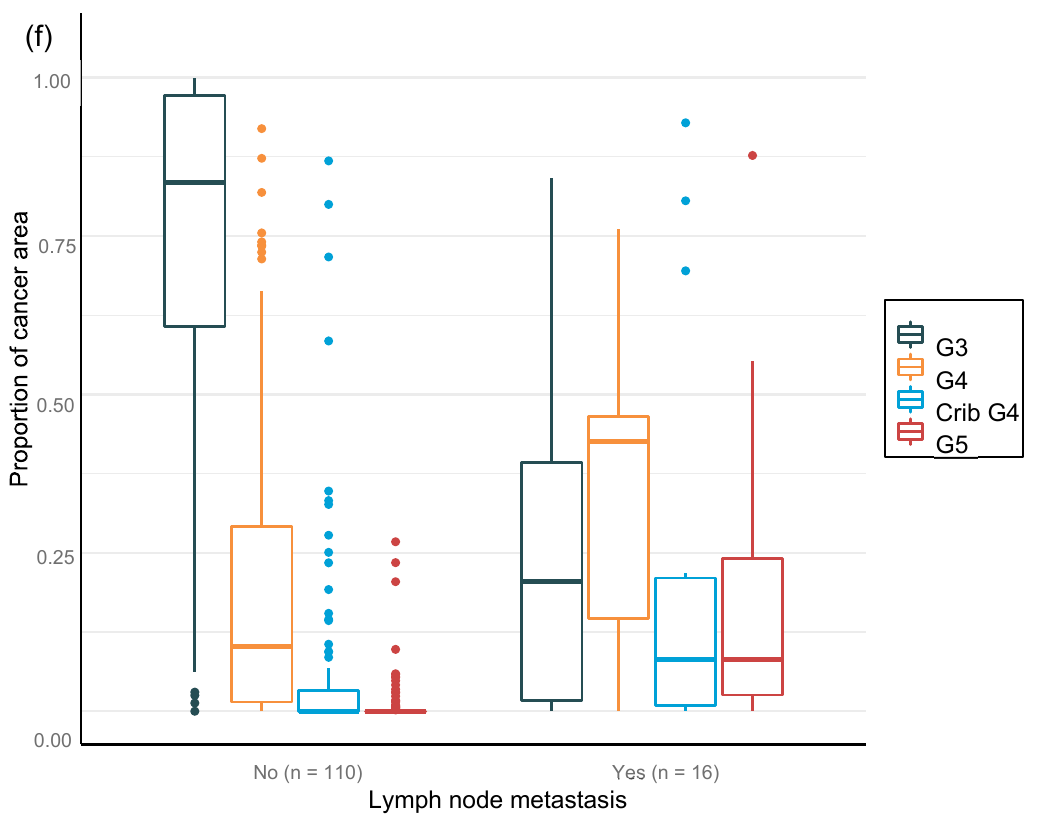
Figure 6. Distribution of Gleason grade in area ( a , c , e ) and percentage of cancer area ( b , d , f ) by AI on biopsy session compared to adverse events non-organ confined ( a , b ), seminal vesicle invasion ( c , d ), and lymph node involvement ( e , f ) at prostatectomy.